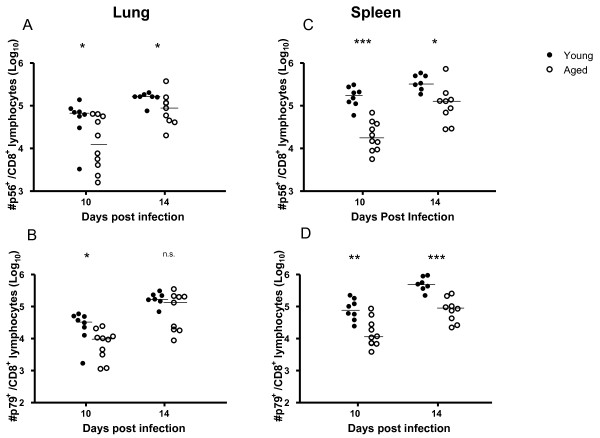
Virus-specific CD8 T cells are generated in aged mice following de novo γHV68 infection. MHC class I tetramer staining and flow cytometric analyses were performed to determine the absolute numbers of ORF6/p56- and ORF61/p79-specific CD8 T cells present in the lungs (A, B) and spleens (C, D) of C57BL/6 mice infected when young (3 months old, closed symbols) or aged (20 months old, open symbols) at the indicated days following de novo γHV68 infection. Symbols represent data obtained from individual mice and bars indicate the medians. Significance was assessed using the Mann-Whitney (two-tailed, 95% confidence). Ns = not significant, * = P ≤ 0.05, ** = P ≤ 0.01, *** = P ≤ 0.001.